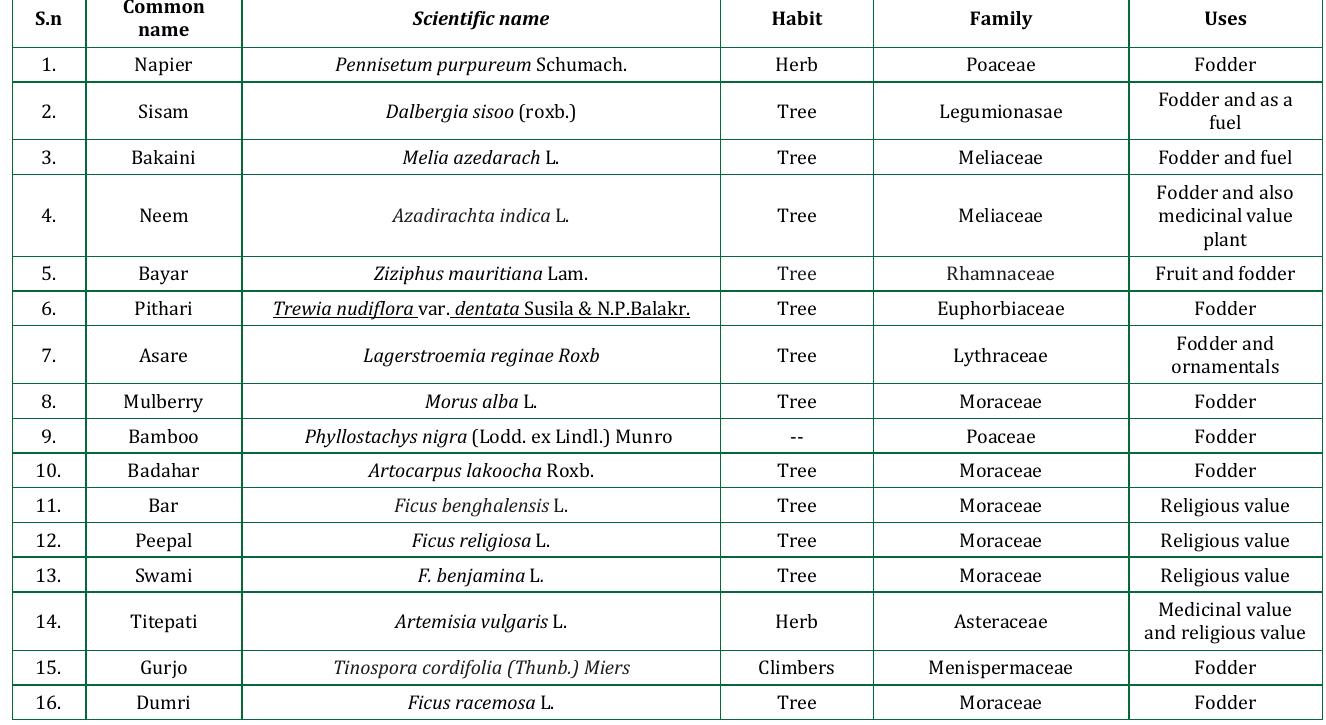
Other crop diversity with multiple uses